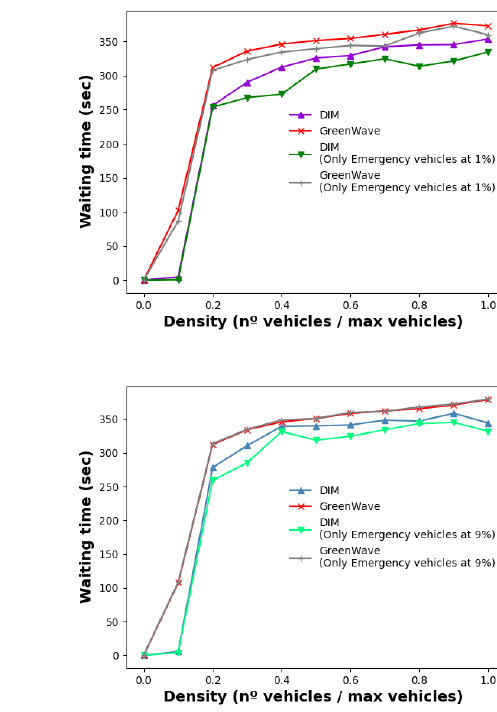
Table 1. Queue lengths and halted vehicles in cities with 200 m between intersections.